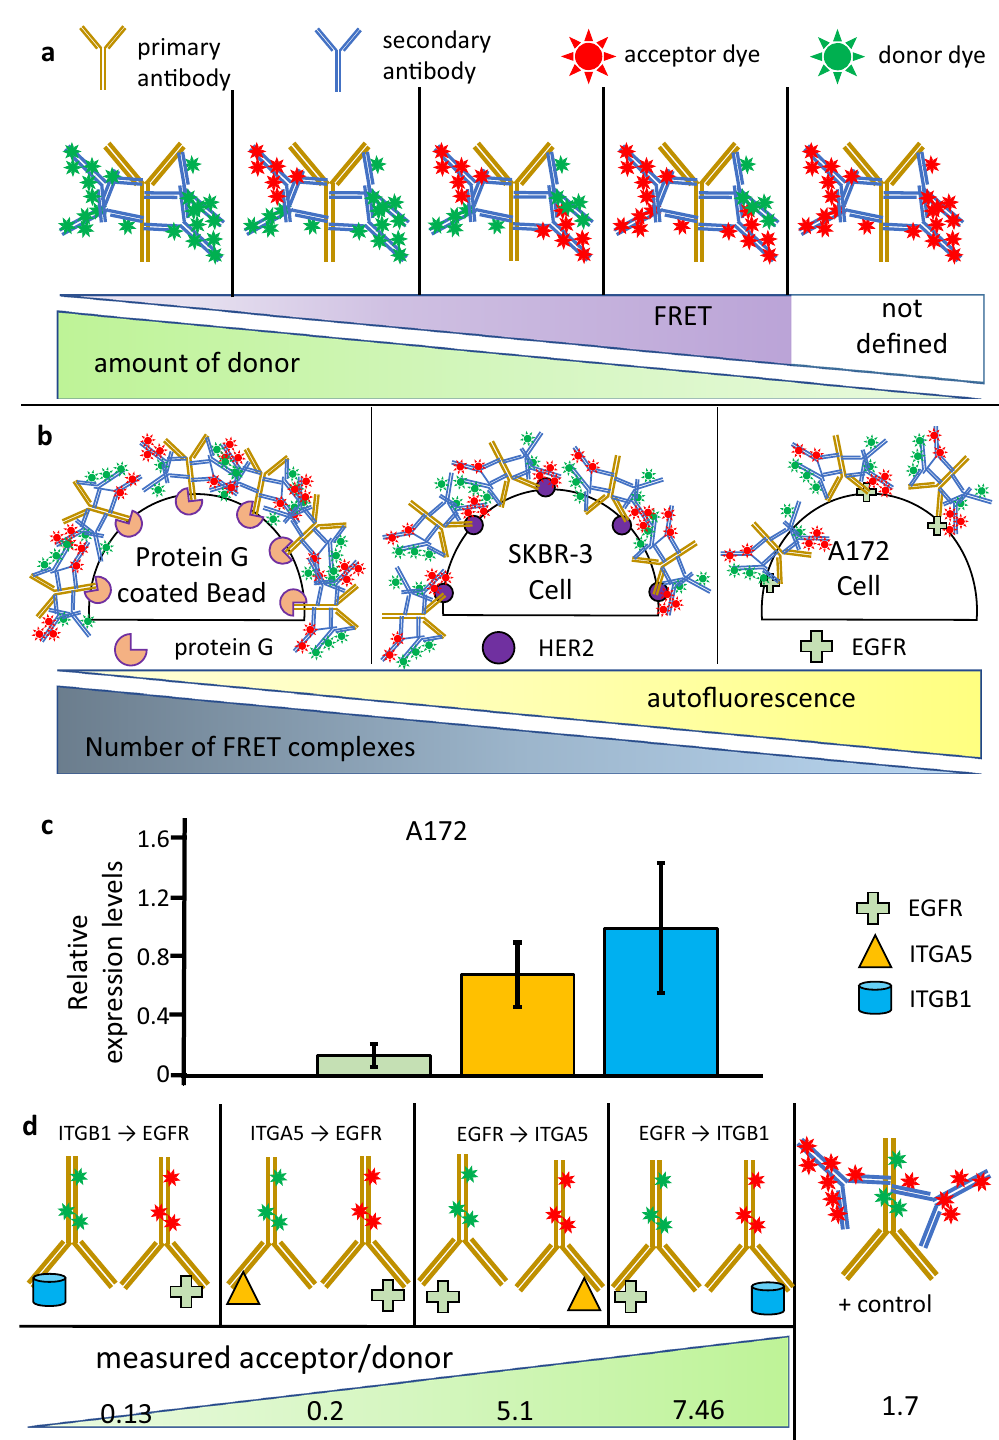
Figure 3. Model systems for testing pixel-by-pixel autofluorescence corrected FRET measurements. ( a ) Schematics of the molecular complexes covering a broad range of acceptor to donor dye ratio in the FRET model systems used. ( b ) Relative amount of the molecular FRET complexes (from panel a ) on protein coated beads and on SKBR-3 and A172 cells, and their relation to autofluorescence intensity. ( c ) Relative expression levels of cell surface proteins on A172 cells. EGFR—EGF Receptor, ITGA5—Integrin α5, ITGB1: Integrin β1. Error bars represent ± SD, n = 6 images, minimum 30 cells. ( d ) Schematics of biologically relevant molecular complexes and the measured acceptor to donor dye ratios between